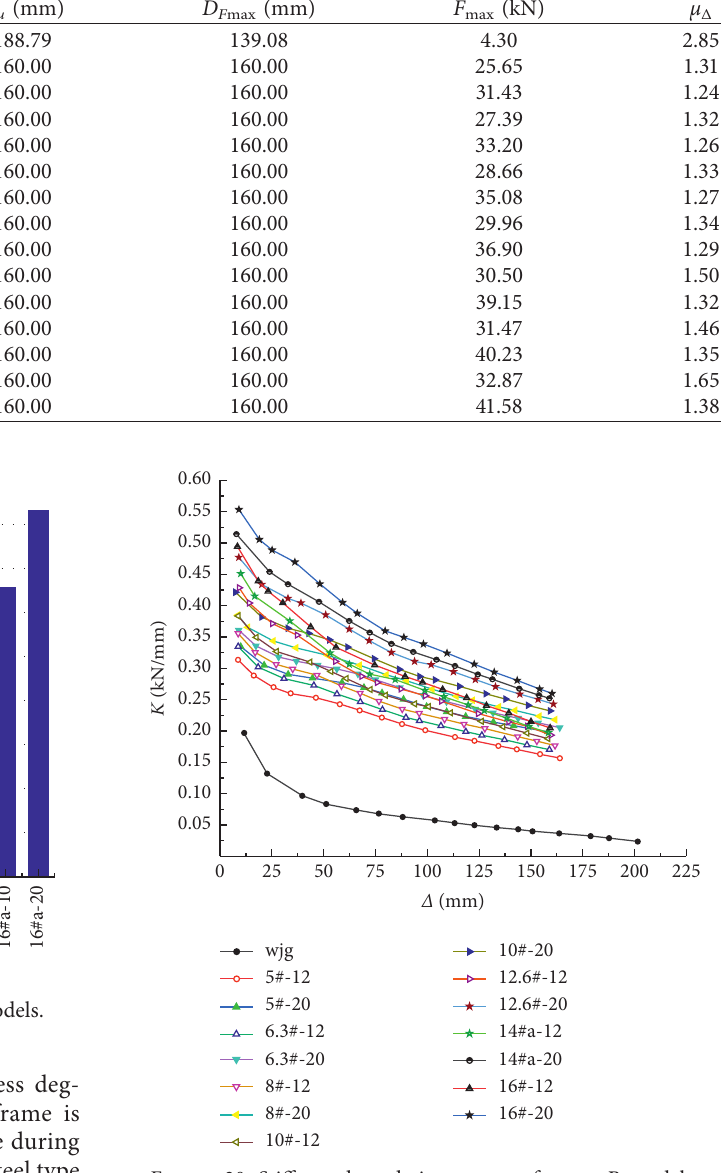
Figure 20: Stiffness degradation curves of group B models.